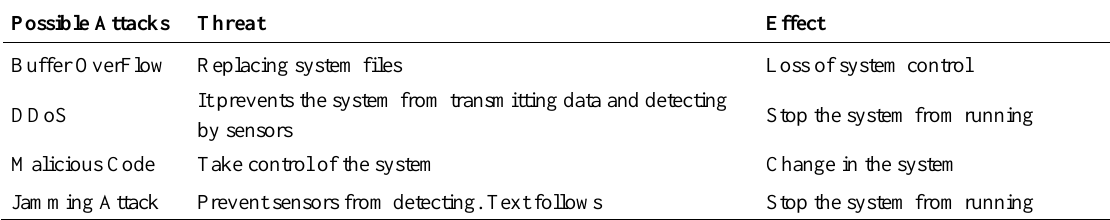
Table 1. Cyber threats and